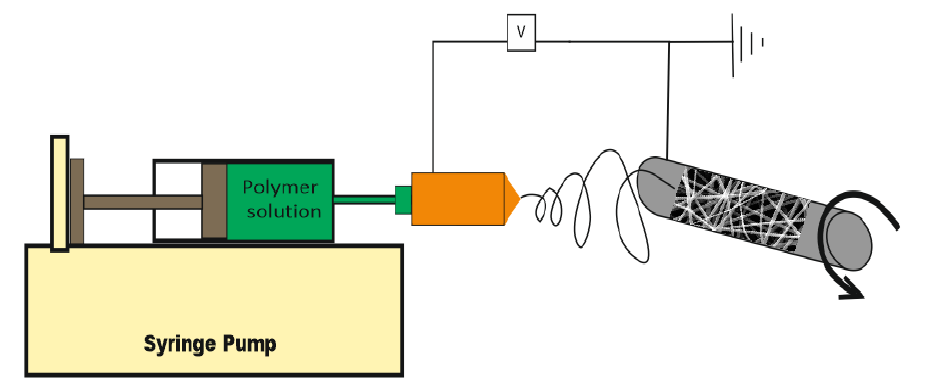
Fig.1. schematic representation of the electrospinning